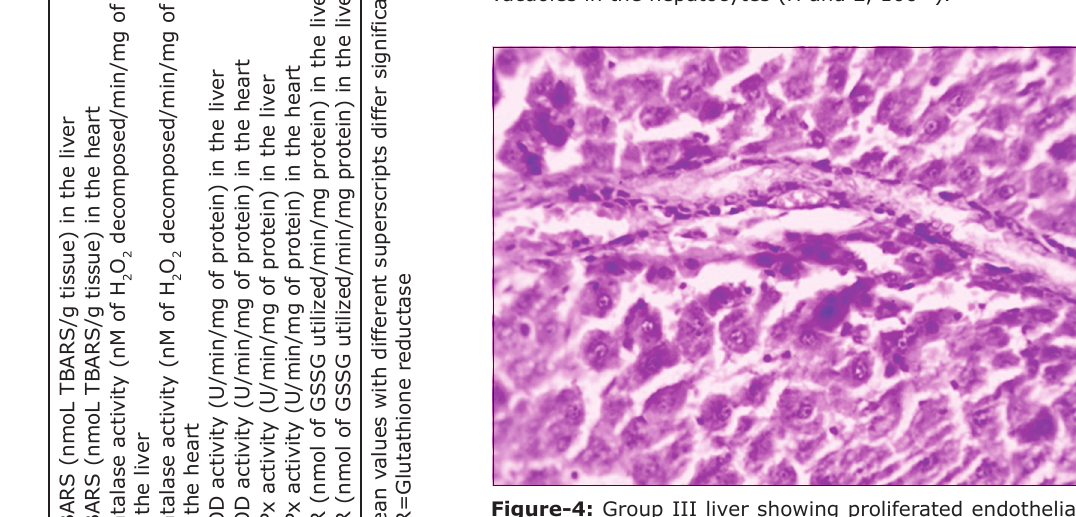
Figure-3: Section of Group IV liver showing few small fat vacuoles in the hepatocytes (H and E, 100×).